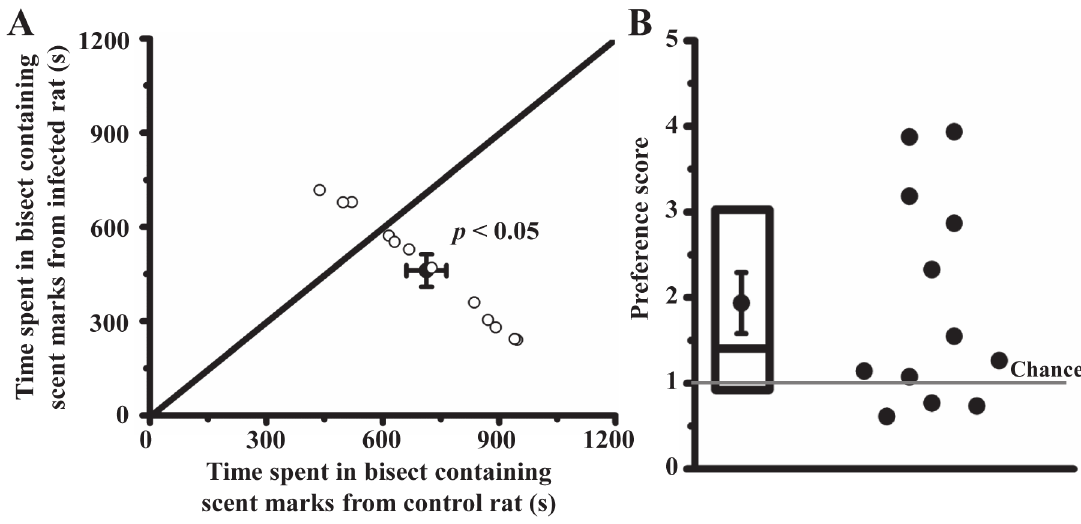
Figure 2. Uninfected mice avoid aged scent marks from infected rats . Preference of mice for control urine marks was retained when aged (3 days old), rather than fresh, rat urine was used. Panel A depicts time spent in the control and infected bisects; Panel B depicts preference ratio (see Figure 1 for further details on what the graphs